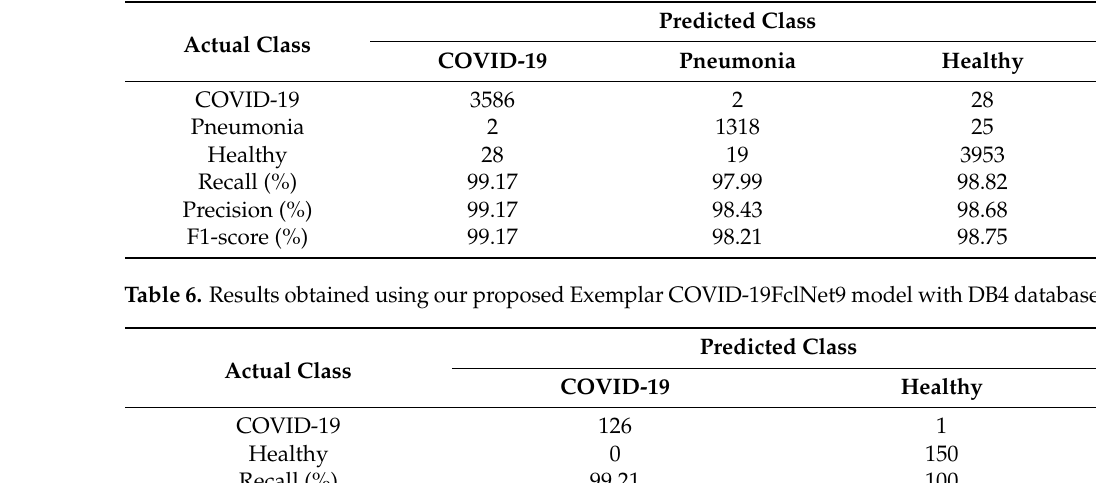
Table 5. Results obtained using our proposed Exemplar COVID-19FclNet9 model with DB3 database.